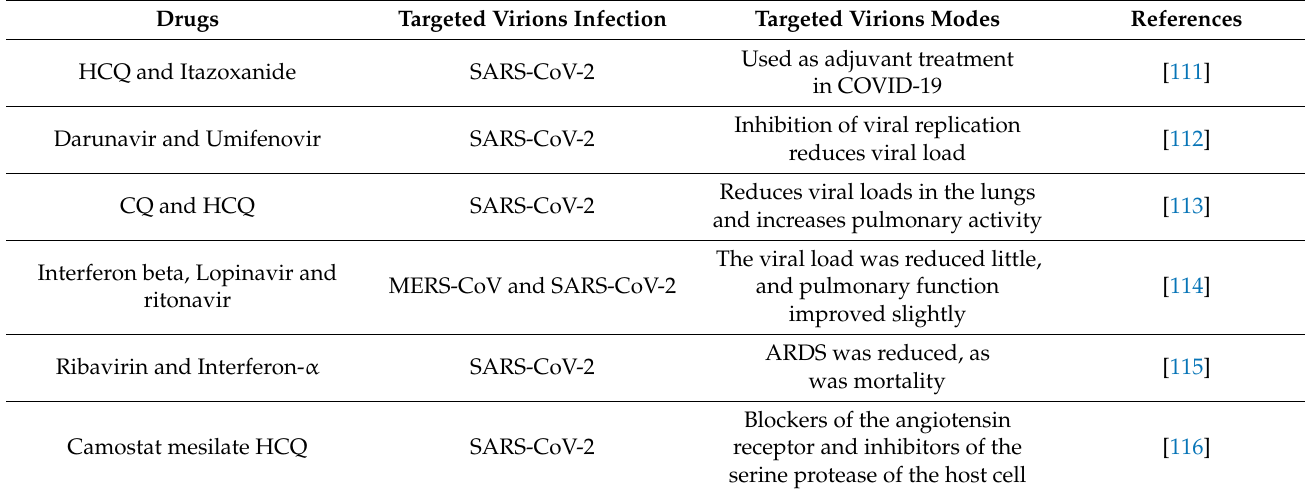
Figure 5. The structures of some effective COVID-19 treatment pharmacological drugs. Table 1. Combinational drugs as potential COVID-19